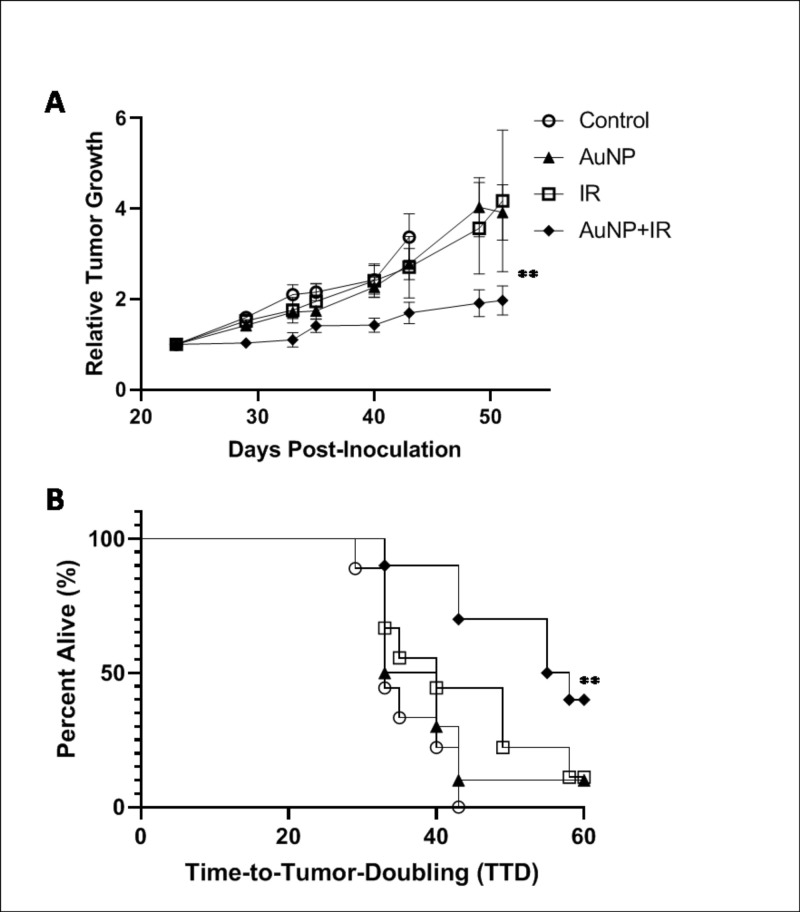
Therapeutic evaluation of tumor vascular disruption.(A) Tumor growth relative to tumor size on day of irradiation is shown. A significant (**P<0.05) delay in tumor growth was observed for AuNP+IR treated mice compared to the controls up to 50 days (n = 9–10). Values represent mean growth ± SD. (B) Time-to-Tumor-Doubling (TTD) is shown with endpoint failure defined as tumor volume doubling relative to day of treatment. A significant (**P<0.05) delay in doubling, which is an indicator of a progressive disease, is seen for mice treated with AuNP+IR compared to all control groups (n = 9–10).